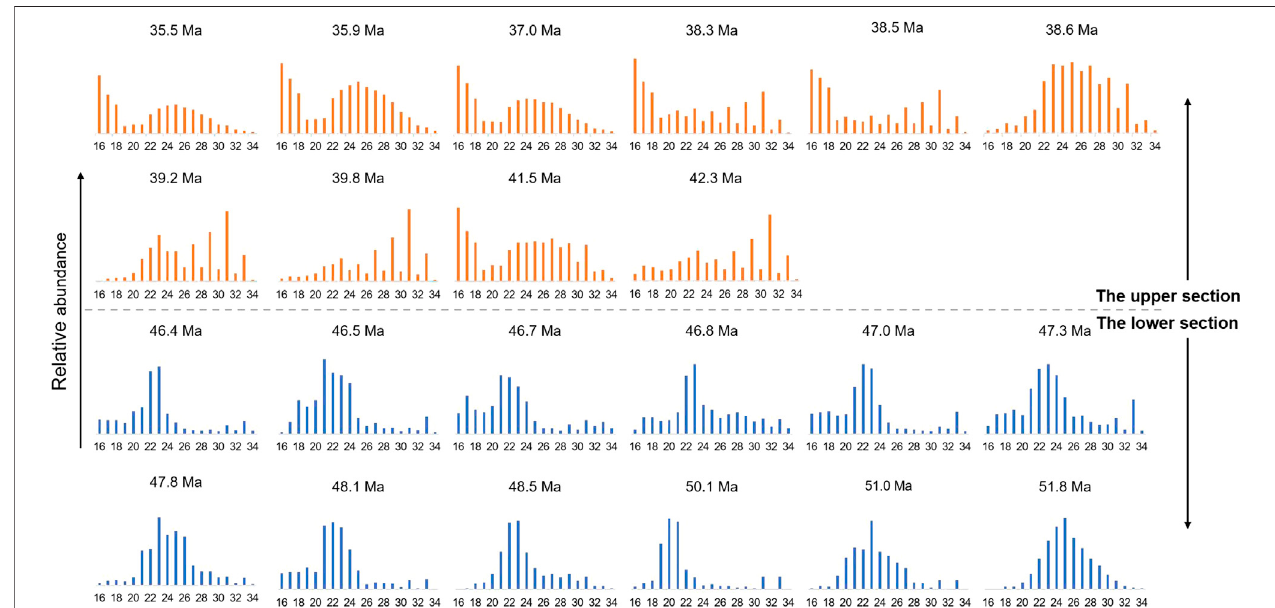
FIGURE 3 | Distribution patterns of n -alkanes in the NB.